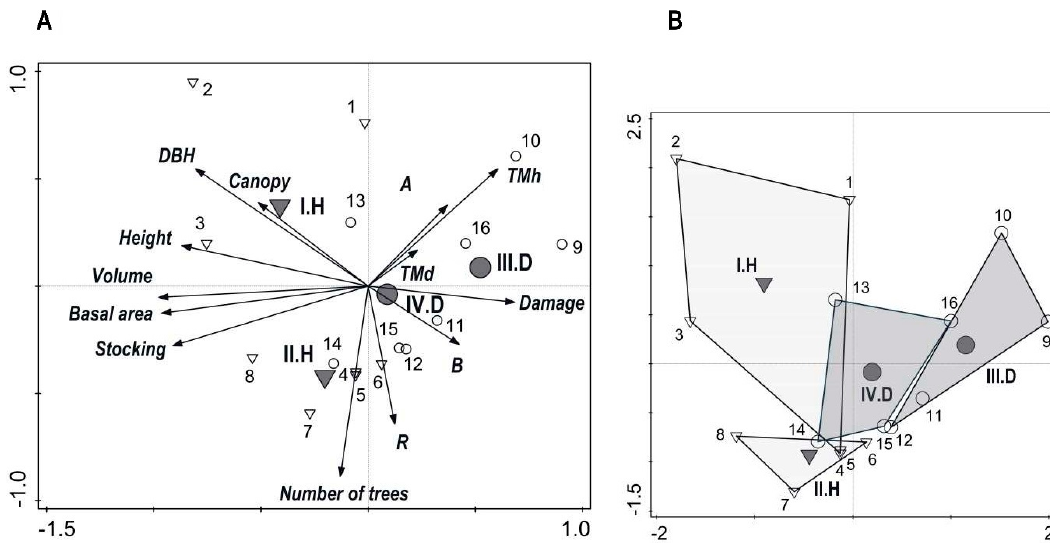
Figure 7. Ordination diagram showing results of Principal Component Analysis (PCA) for the relationships among production parameters of stand (mean DBH , mean Height , Basal area , Volume , Stocking SDI, Canopy Crown projection area), diversity ( A Arten-profile index, R aggregation index, TMd diameter differentiation index; TMh height differentiation index, B total diversity index), and game damage ( Damage ). Plot symbols: ● plot with low game damage (LD plot), and ▼ plot with high game damage (HD plot). Numbers: 1–16—plot ID, and I.–IV.—locality.